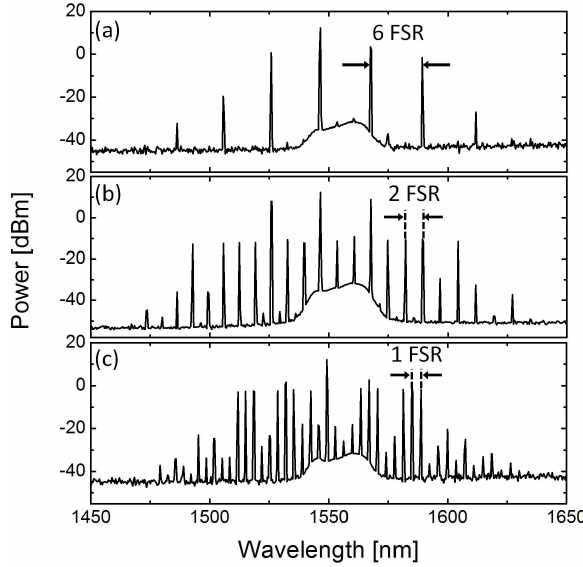
Figure 5: Frequency comb generation sequence. (a) When the opti- cal circulating power is just above the comb threshold. (b) By tuning the input wavelength closer to resonance, more peaks are gener- ated by the increased power in the micro-ring. (c) Full comb with repetition rate of one FSR by further input wavelength tuning.